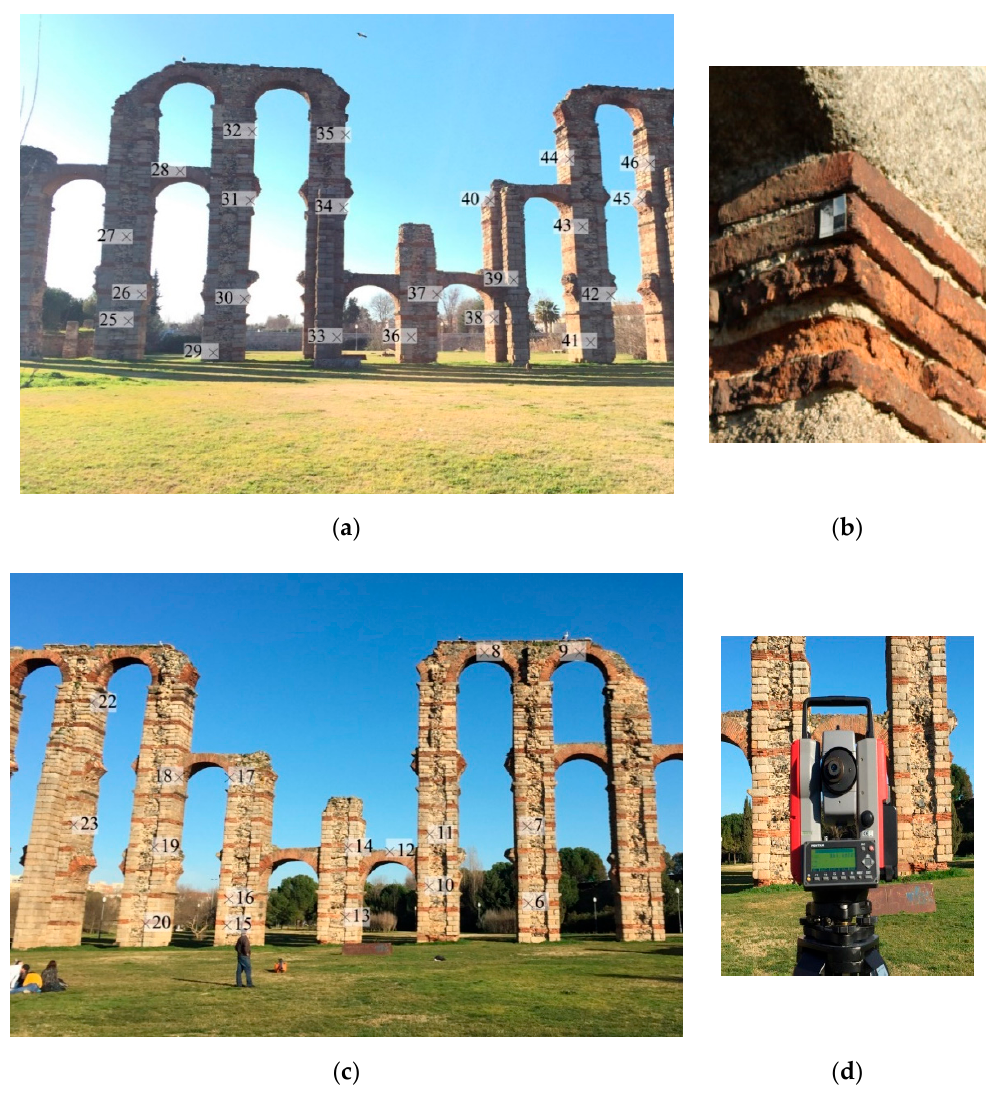
Figure 6. ( a , c ) Reference points spread on the two fronts of the monument. ( b ) Target model used in the test and ( d ) total station Pentax V-227N used to measure the network coordinates.